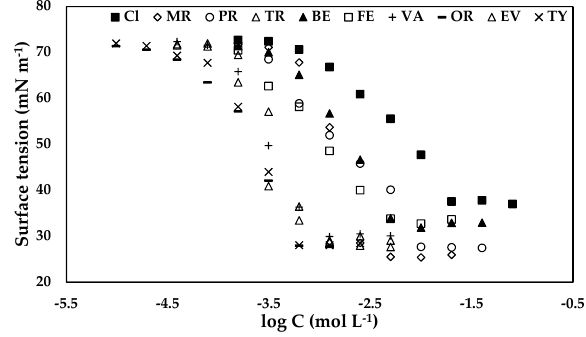
Figure 3. Surface tension vs. log C at 25 °C. Table 5. Surface active parameters of imidazolium